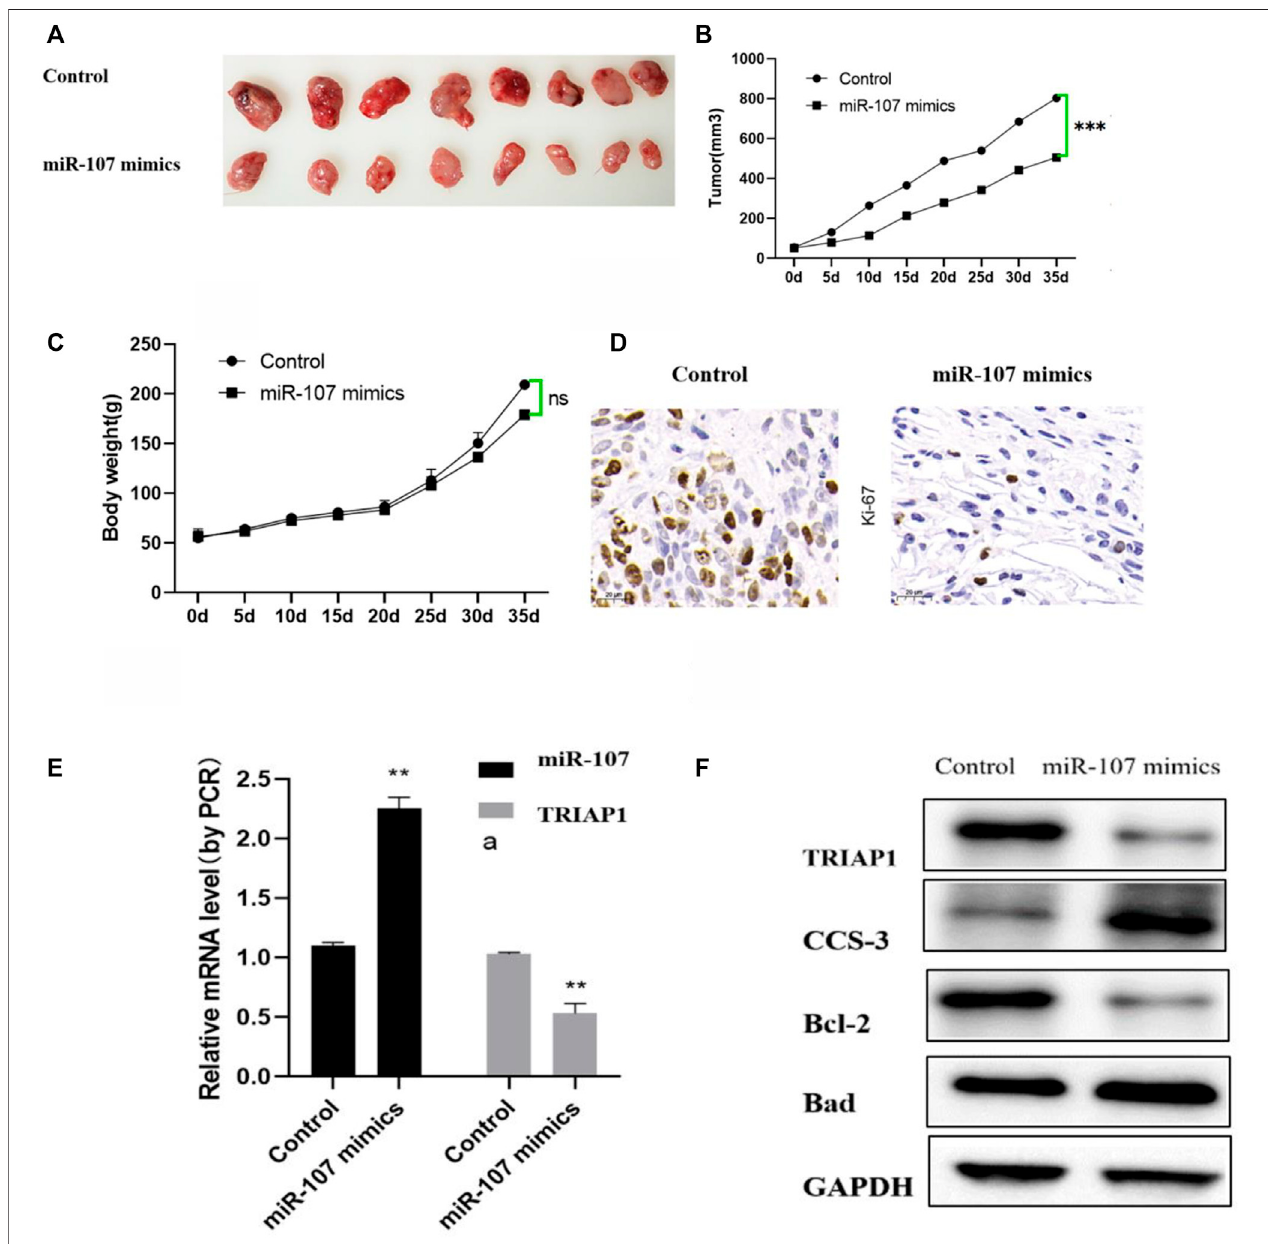
FIGURE 6 | miR-107 inhibits tumor progression in vivo. (A) Representative pictures of tumors after different treatments, (B) Tumor progression after different treatments, (C) Mousebodyweightchangesafterdifferenttreatments, (D) ImmunohistochemicalanalysisofKi-67expressionintumortissues(originalPictureX100), (E) Expression levels of miR-107 and TRIAP1 in tumor tissue, (F) Expression levels of TRIAP1 and apoptosis-related proteins in tumor tissues, Compared with the control group, * p < 0.05,** p < 0.01, *** p <